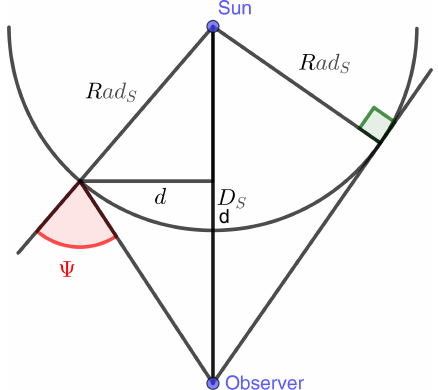
Figure 4. Definition of the angle (cid:57) used in the equations for the limb darkening coefficient. If d , D S and Rad S = 695 . 700km are given, it is possible to derive (cid:57) using simple trigonometric rela- tions.